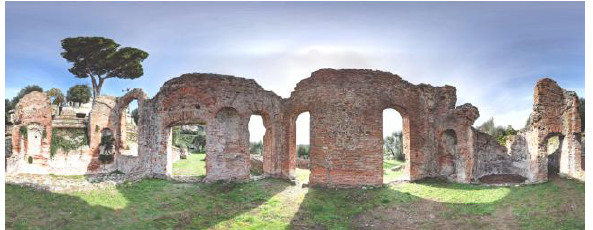
Figure 4. Spherical panorama of the thermal area, the frigidarium (H, I, L in Figure 2). The high quality is obtained by using an external camera, Canon EOS 5D mark II